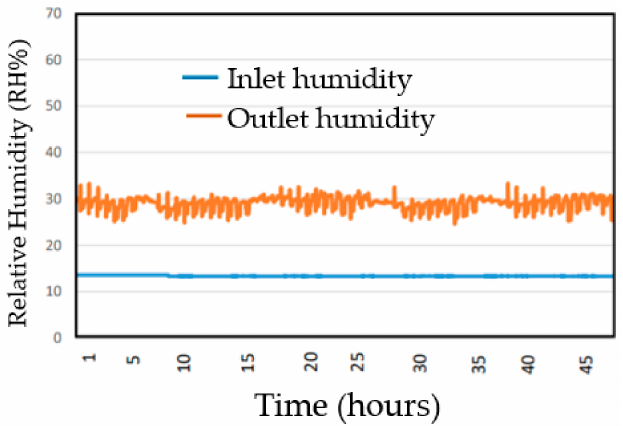
Figure 10. The measurement di ff erence in relative humidity between the inlet and outlet of the chamber connected to the third heat pump with auxiliary